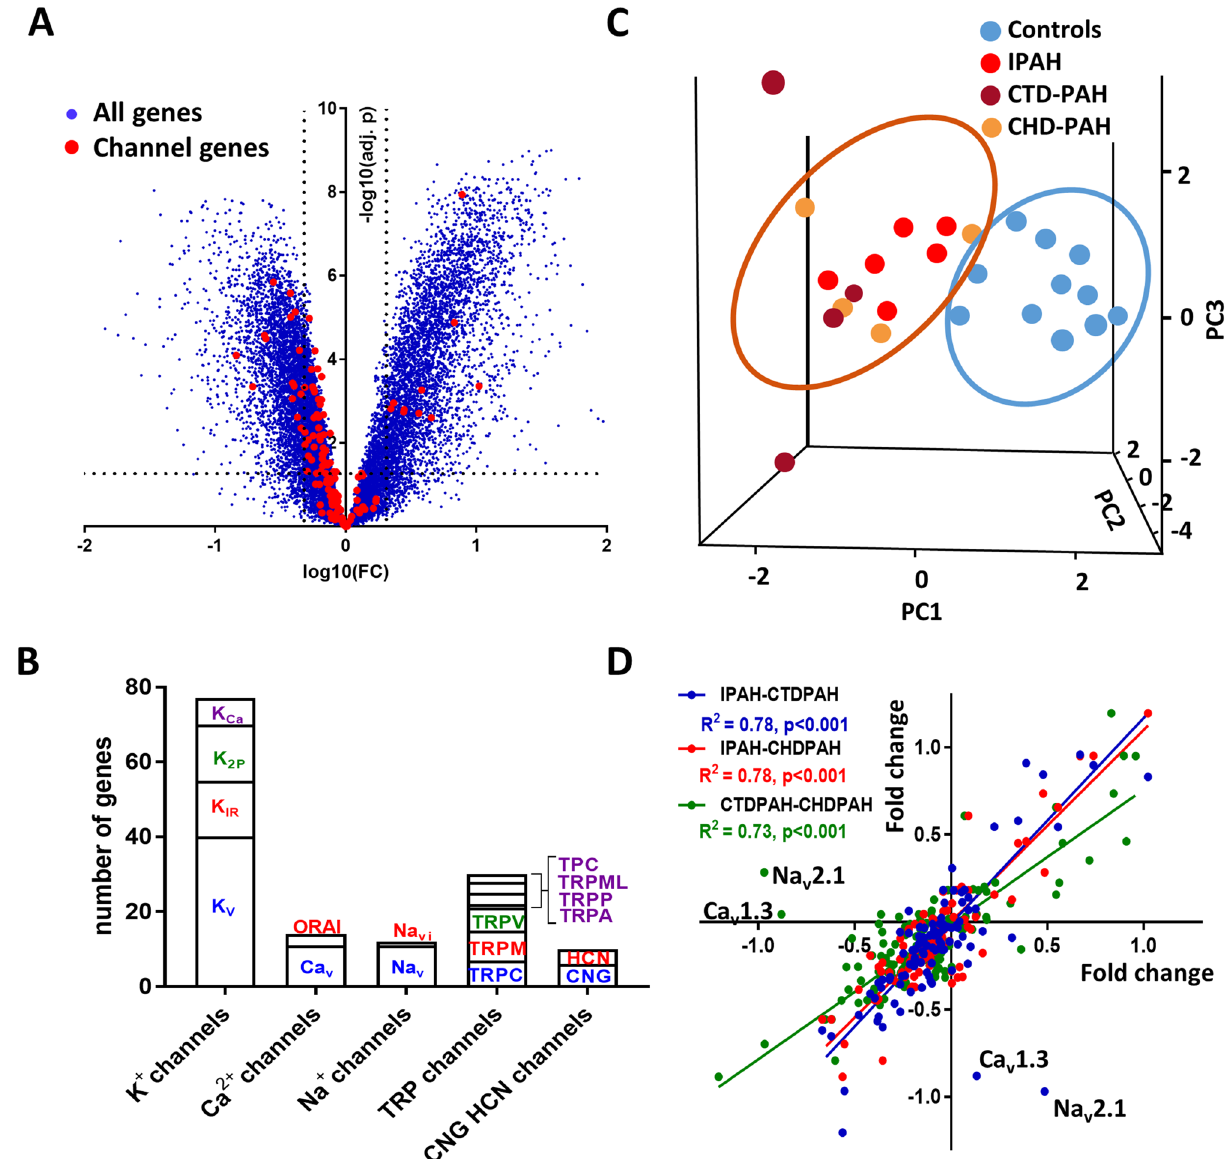
Figure 1. Channel gene expression profile analysis in pulmonary arterial hypertension. ( A ) Vulcano plot [log fold change against − log (adjusted p value)] showing the changes in mRNA transcripts for all identified genes (blue) and for cationic channel encoding genes (red). The vertical lines correspond to twofold up and down, respectively, and dots above the horizontal dotted line indicate adjusted p < 0.05. ( B ) Families and subfamilies of mRNAs encoding the pore forming alpha subunits of cationic channels identified in the control samples, ( C ) 3D principal component analysis performed with the 143 channel encoding mRNAs. ( D ) Regression analysis of the changes (fold change vs control) in the different subgroups of PAH: idiopathic PAH (IPAH), connective tissue disease associated PAH (CTD-PAH) and congenital heart disease PAH